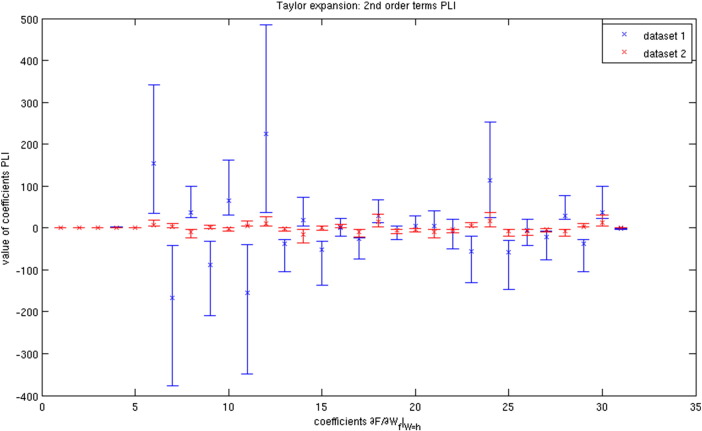
Predicted resting state network connectivity. Predicted connectivity was grouped within a RSN, and predicted connectivity between the same RSN and all surrounding regions was grouped. We display the difference in median between these two groups for the salience, sensorimotor, default mode, executive, visual and combined left and right fronto-parietal networks. The upper panel shows the AEC based prediction and the lower panel the PLI based prediction. The colours correspond to the model used, ranging from single frequency to non-linear model with cross-terms. Note that for both functional connectivity metrics, the contribution of non-linearity leads to better identification of RSNs (apart from DMN PLI). * refers to significant differences only if the difference had the right sign (within > between; p < 0.0005 (Bonferroni corrected)), x refers to significant differences with the right sign (within > between; p < 0.0005 (Bonferroni corrected)) and when the outliers were discarded in the distributions.